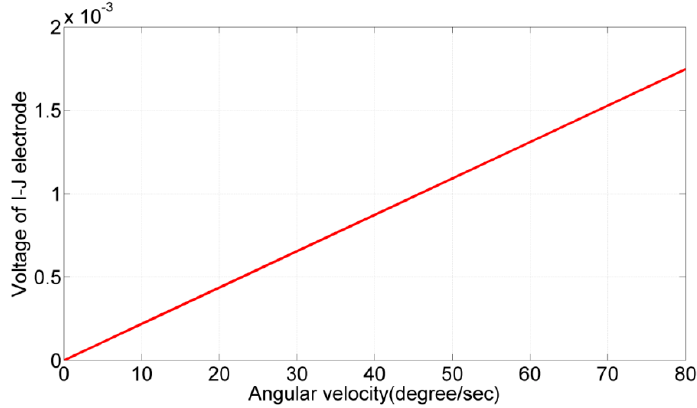
Figure 11. Angular rate measurement and predicted output voltage. The sensitivity was 13.8 µ V/deg/s, and the nonlinearity is 0.6% in FSO.